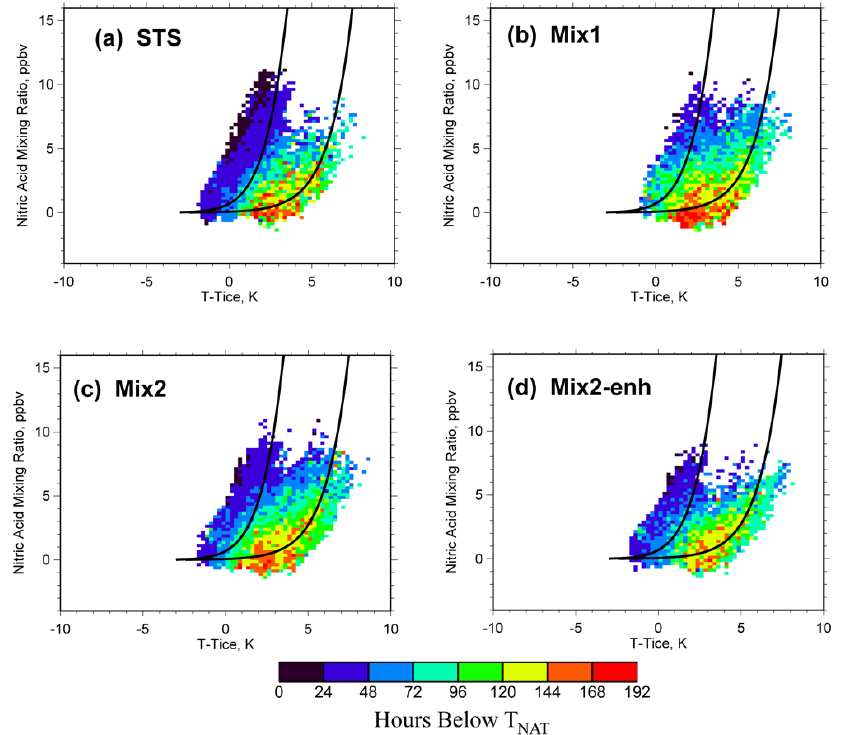
Fig. 5. Temperature histories for CALIOP Arctic PSC observations at 490K potential temperature during 1 December 2009–31 January 2010 for (a) STS, (b) Mix 1, (c) Mix 2, (d) Mix 2-enh. The histogram bin size is 0.25ppbv × 0.25K and the color scale indicates the average number of hours each air parcel associated with CALIOP PSC observations falling within each bin was exposed to temperatures below T NAT . Black lines are reference equilibrium uptake curves for STS (left) and NAT (right) assuming 16ppbv HNO 3 and 5ppbv H 2